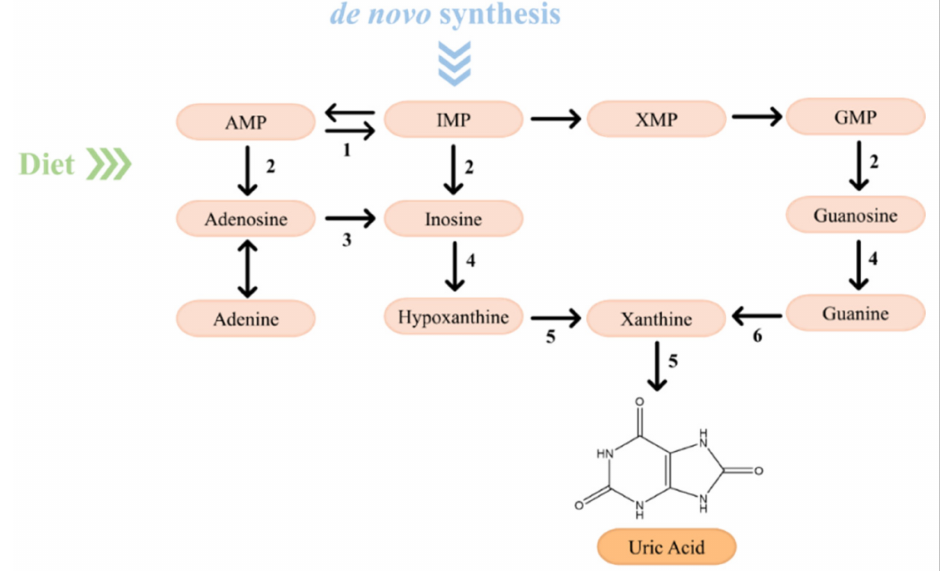
Figure 7. Overview of the purine catabolism into uric acid. The enzymes involved are represented by numbers: (1) AMP deaminase, (2) nucleotidase, (3) adenosine deaminase, (4) purine nucleoside phosphorylase (PNP), (5) xanthine oxidase and (6) guanine